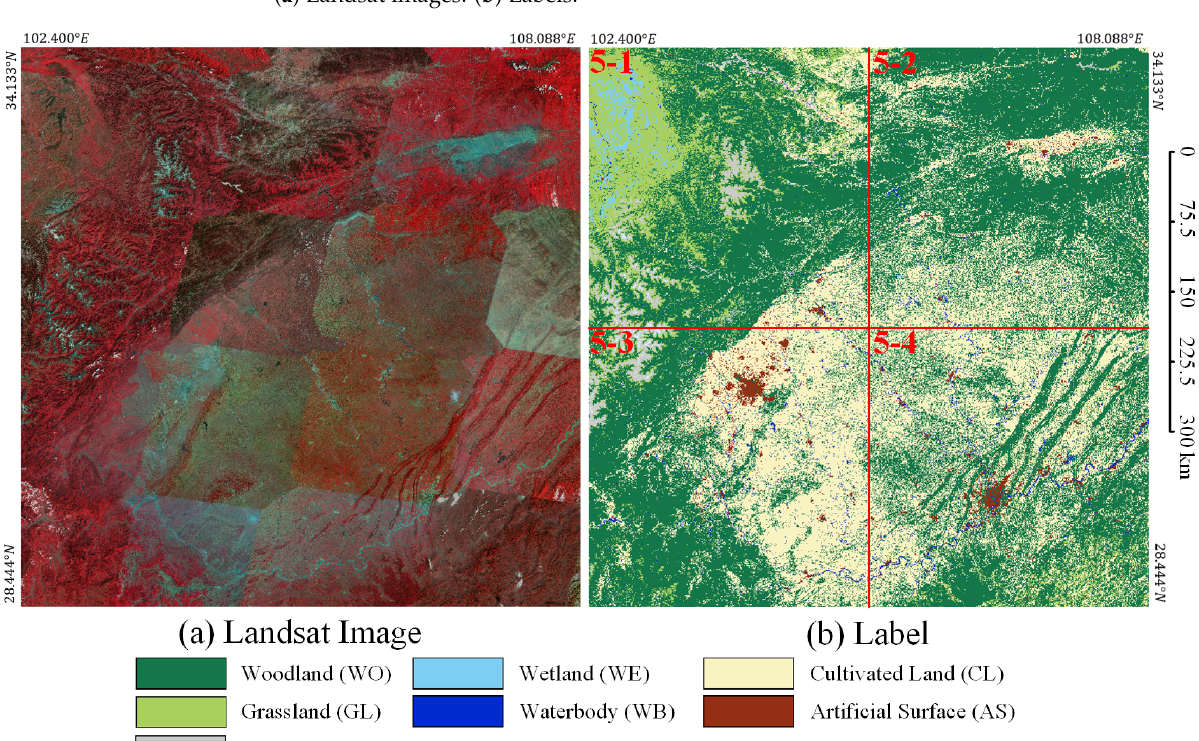
Figure 9. Geographical distribution of Landsat supplement dataset in Region SW. LSS dataset IDs: 5-1, 5-2, 5-3, 5-4. ( a ) Landsat images. ( b )